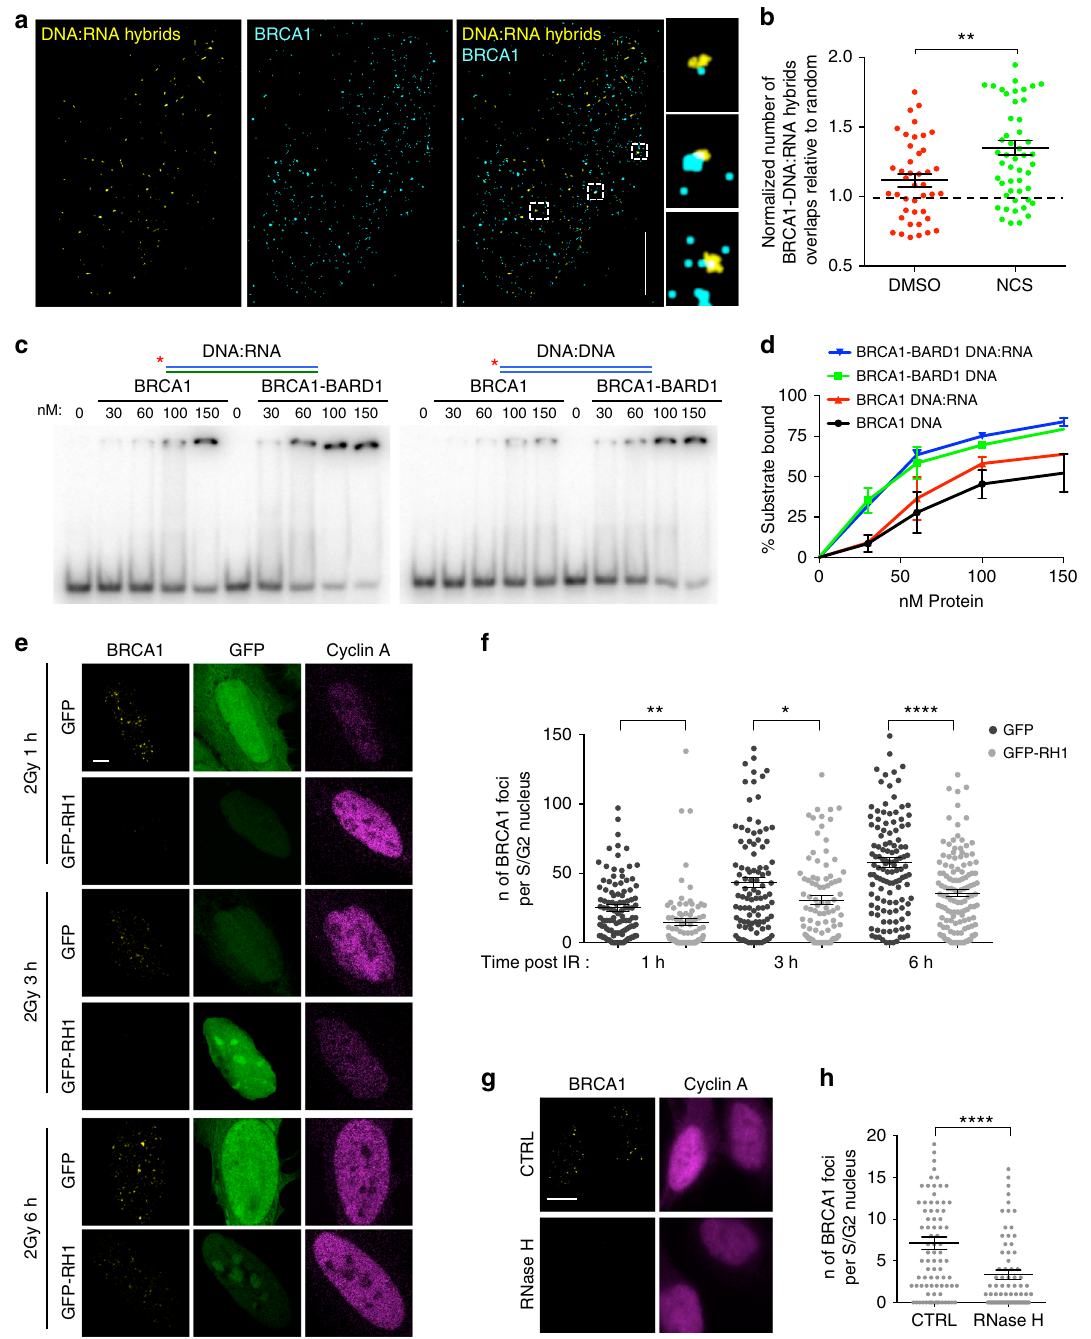
Fig. 4 DNA:RNA hybrids are directly recognized by BRCA1 in vitro and in vivo. a Representative pictures of super-resolution imaging analysis of BRCA1 (cyan) and DNA:RNA hybrids (yellow) colocalization in S-phase synchronized NCS-treated U2OS cells. Scale bar: 5 μ m. b Dot plot shows the normalized number of overlaps relative to random of BRCA1 and DNA:RNA hybrids signals in S-phase U2OS cells treated with DSMO or NCS. At least n = 40 events were counted from three independent experiments. Lines represent mean ± s.e.m. c Electrophoretic mobility shift assay (EMSA) of puri fi ed recombinant human BRCA1 or BRCA1-BARD1 with end-labeled (*) double-stranded DNA or DNA:RNA substrates. d Graph showing the percentage of protein-bound substrate at respective protein concentrations. Error bars represent s.e.m. ( n = 2 independent experiments). e Representative images of BRCA1 foci co- stained with cyclin A, as S/G2-phase marker, in irradiated (2 Gy) U2OS cells over-expressing GFP or GFP-RNase H1 (GFP-RH1). Scale bar: 5 μ m. f Dot plot shows the number of foci in e . At least n = 80 cells were counted from at least three independent experiments. Lines represent mean ± s.e.m. g Representative images of BRCA1 foci co-stained with cyclin A, as S/G2-phase marker, in irradiated (2 Gy) U2OS cells treated with RNase H prior to fi xation. Scale bar: 10 μ m. h Dot plot shows the number of foci in g . At least n = 80 cells were counted from three independent experiments. Lines represent mean ± s.e.m. * P < 0.05, ** P < 0.01, **** P < 0.0001 (two-tailed Student ’ s t test). Source data are provided as a Source Data fi